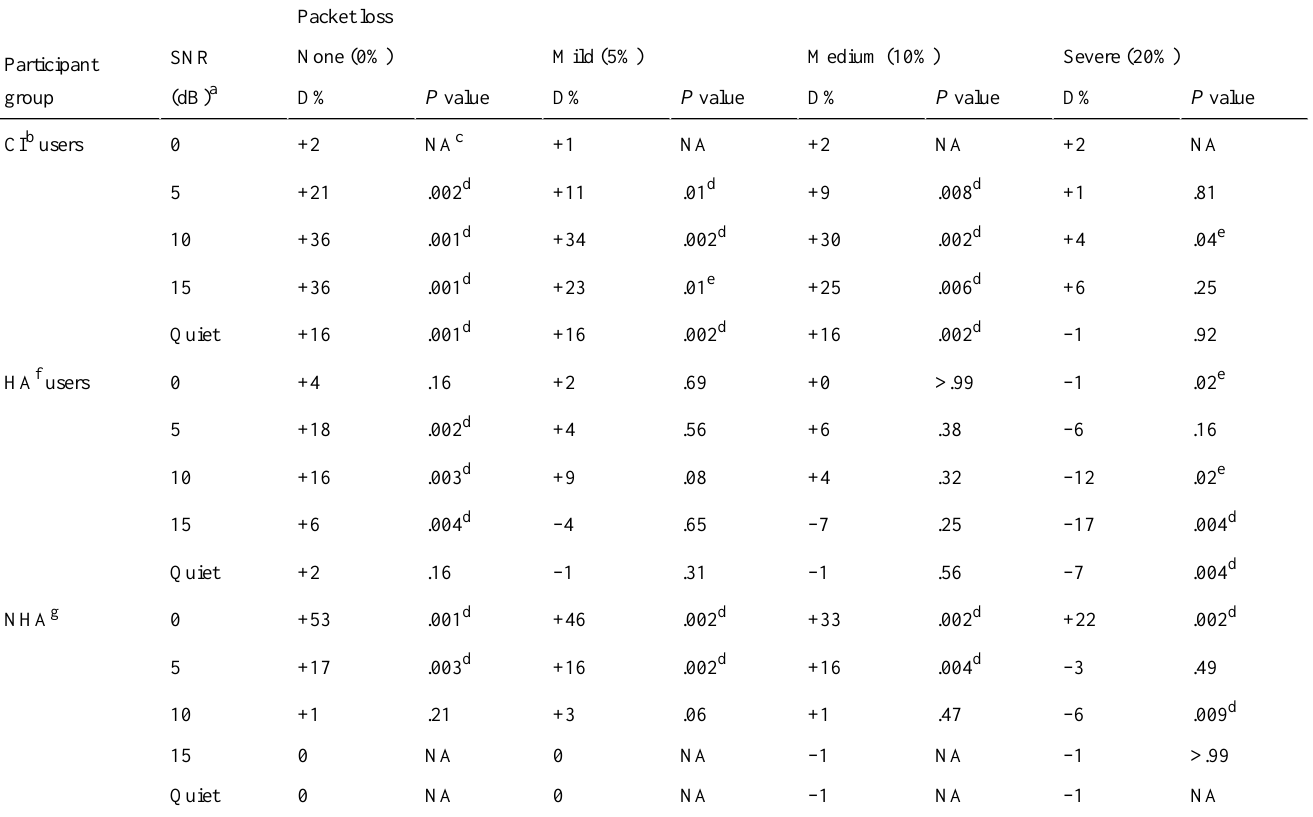
Table 4. Mean differences in speech perception scores (D%) assessed with different voice over Internet protocol qualities (degree of packet loss)